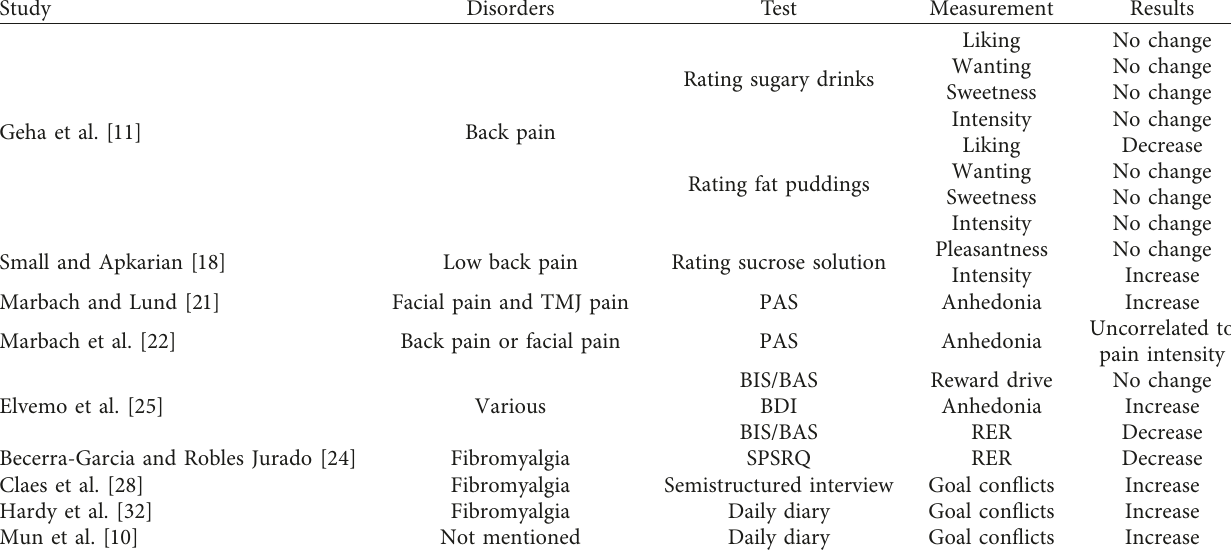
Table 1: Reward-related behaviors in patients with chronic